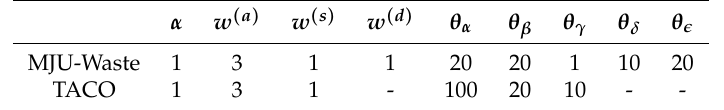
Table 2. CRF parameters used in our experiments. Depth terms are not applicable to the TACO